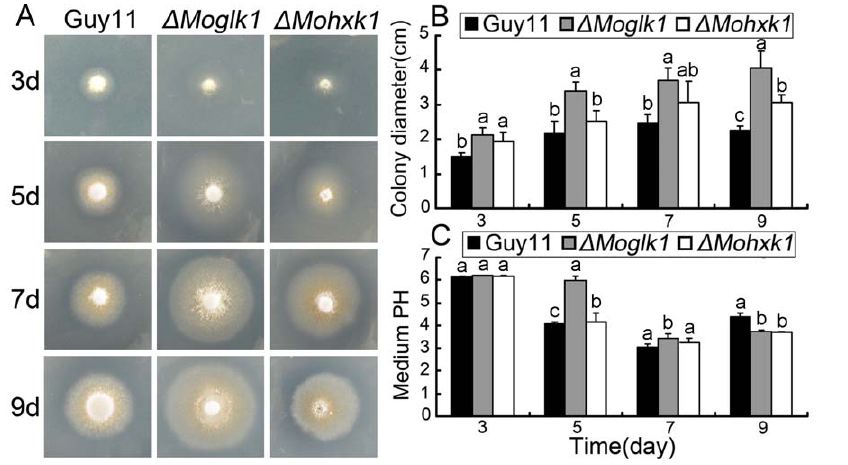
Figure 1. Ammonium utilization of D Moglk1 and D Mohxk1 mutants. Guy11, D Moglk1 and D Mohxk1 mutant s were grown on MM containing 1% glucose and 100 mM ammonium. Photographs (A) were taken from one transformant of each mutant at indicated days after incubation at 30 u C. Colony diameter (B) and medium pH (C) were measured at the same days. The experiment was performed with three strains for the D Moglk1 and D Mohxk1 mutant s, respectively; and three independent replicates provided the same results. Different letter represent difference (P , 0.05) among Guy11 and D Moglk1 , D Mohxk1 .